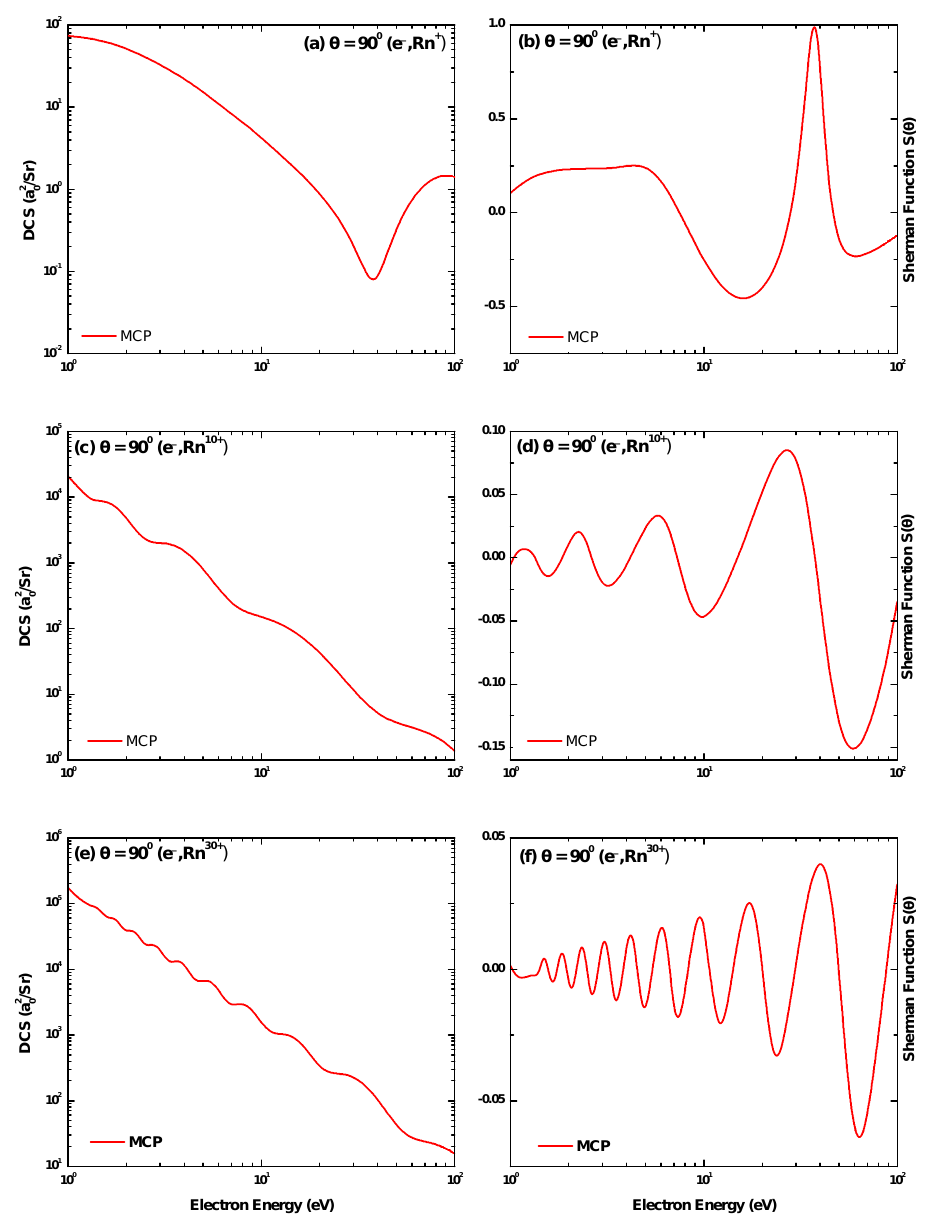
Figure 26. Energy dependent DCS and corresponding Sherman function for the elastic scattering of electrons from ( a , b ): Rn + , ( c , d ): Rn 10 + and ( e , f ): Rn 30 + at fixed scattering angle θ = 90 ◦